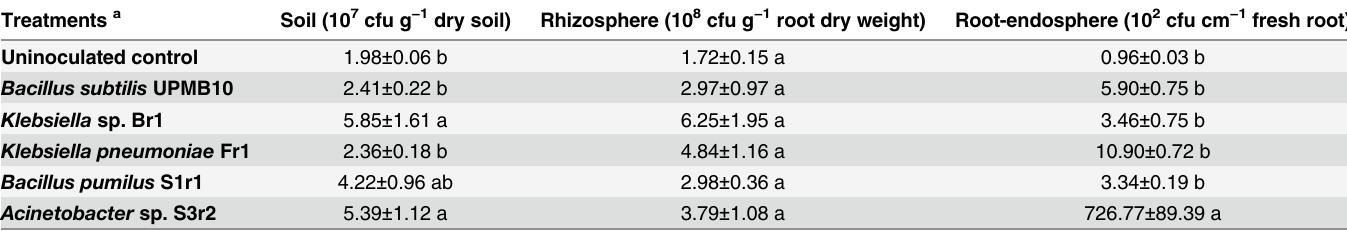
Table 2. Total bacterial population at ear harvest (D 65